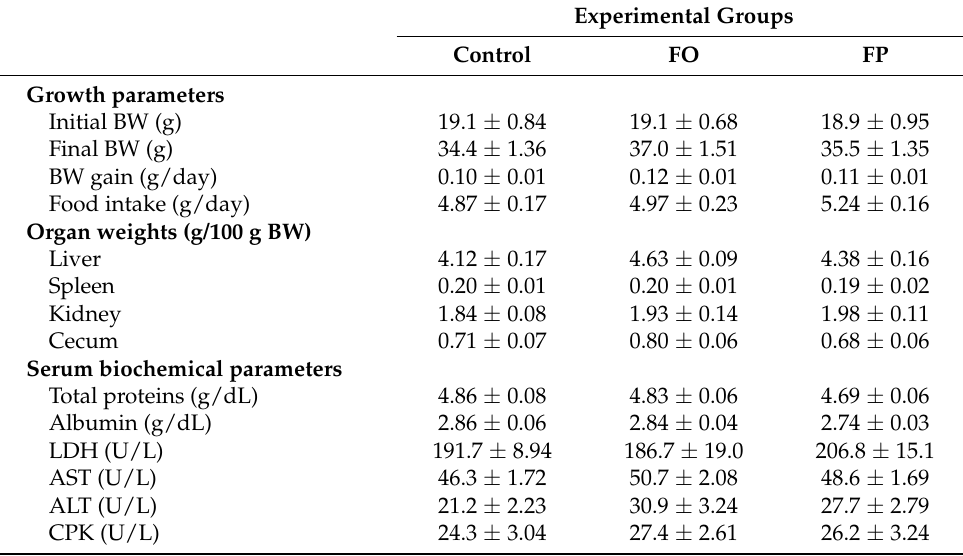
FO = fish oil. FP = fish protein. BW = body weight. LDH = lactate dehydrogenase. AST = aspartate aminotransferase. ALT = alanine aminotransferase. CPK = creatine phosphokinase. All data are presented as the mean ± standard error of the mean (n = 10 mice for control and FP, n = 7 for FO).